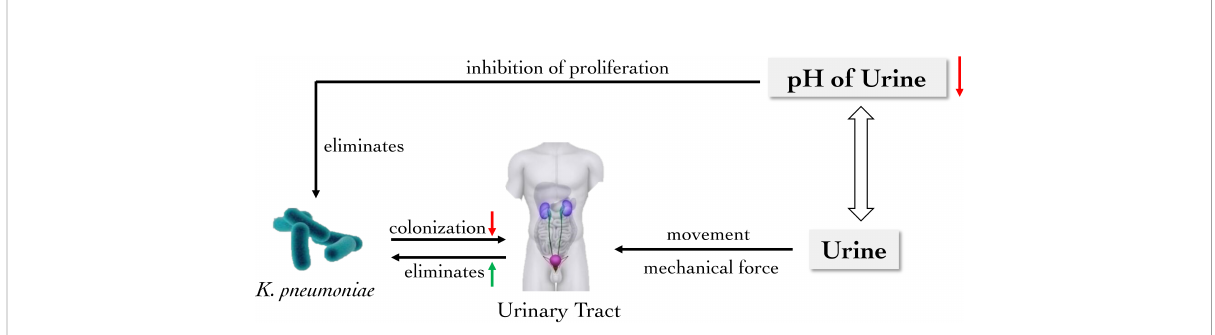
FIGURE 2 The main role of urinary barrier against K. pneumoniae . The mechanical force generated by the fl ow of urine removes K. pneumoniae from the urinary tract, which is also an important physical barrier to reduce bacterial colonization. Moreover, the reduction of urinary pH inhibits the proliferation of K. pneumoniae in the urinary tract.